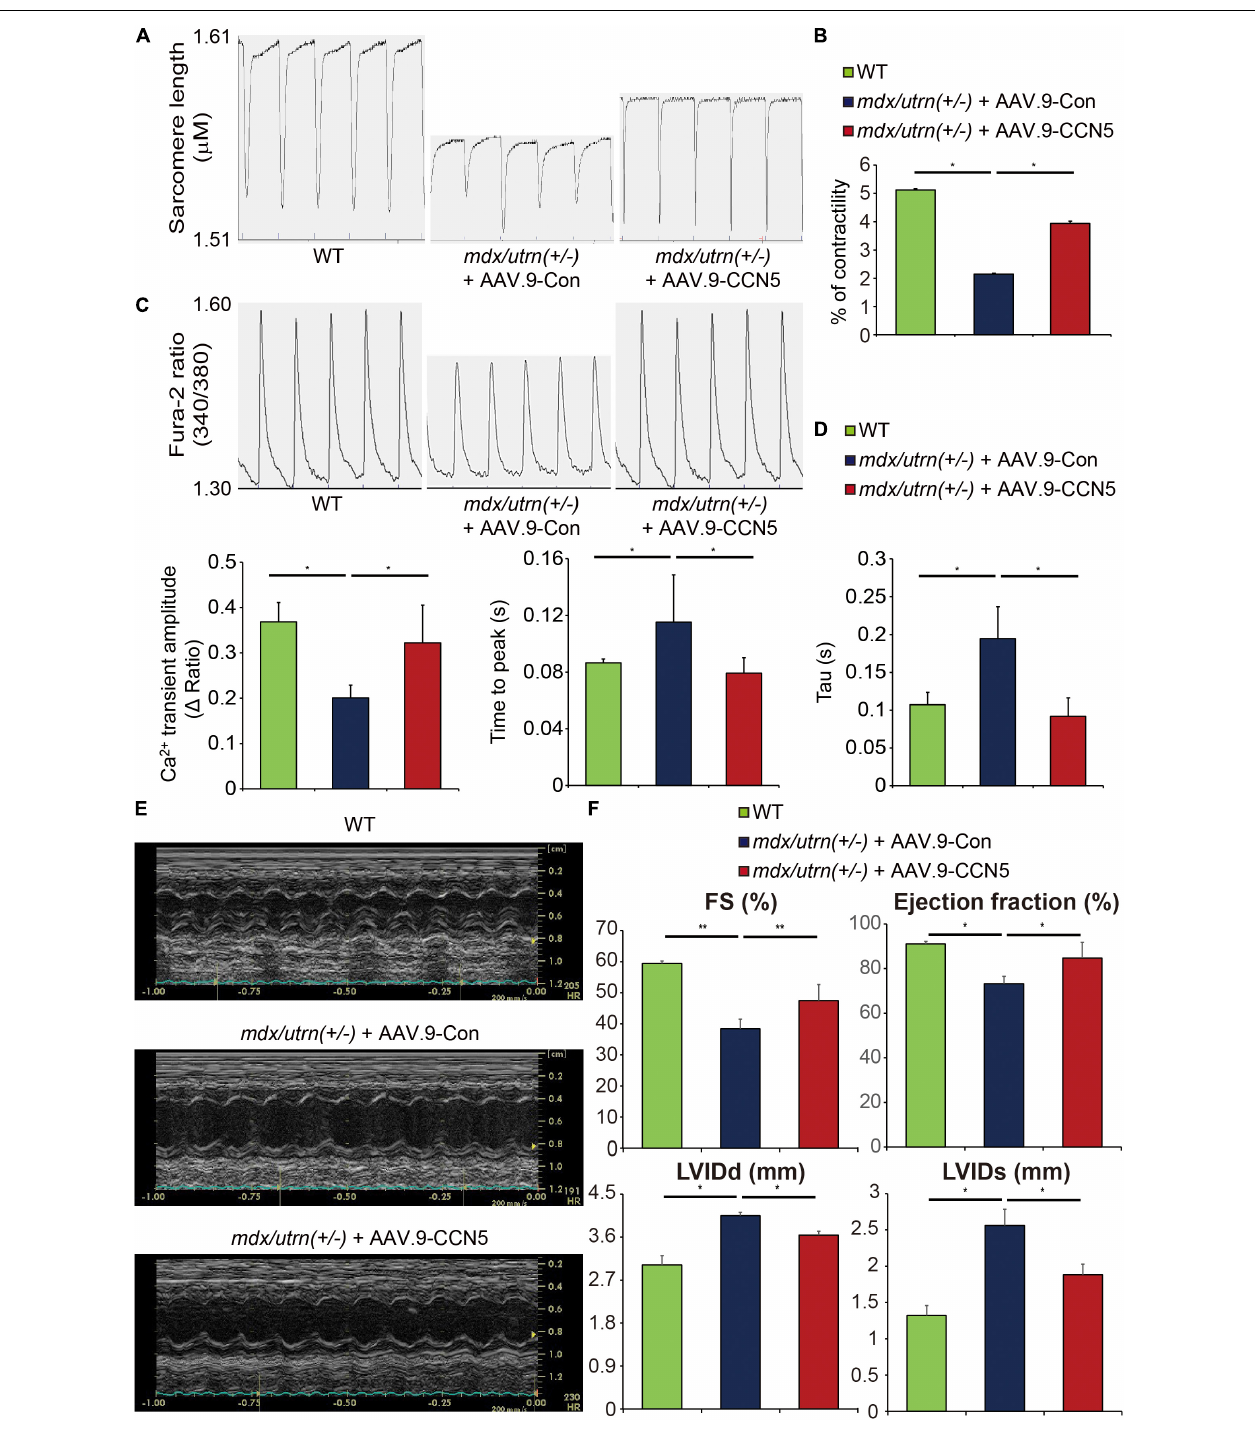
FIGURE 2 | CCN5 reduces cardiac dysfunction in mdx/utrn ( ± ) mice. (A) The Langendorff system was used to isolate cardiomyocytes. Traces of the sarcomere length were measured in the isolated cardiomyocytes. (B) Average contractility was calculated and analyzed. n ≥ 40 for analyzing the contractility. (C) Traces of the Fura-2 ratio of Ca 2 + transients were measured in the isolated cardiomyocytes. n ≥ 40 for analyzing the Ca 2 + transient parameters. (D) Average Ca 2 + transient amplitude, time to peak and Tau were calculated and analyzed. (E) Representative images of echocardiogram are shown. (F) FS, LVIDd, LVIDs and EF were measured to analyze cardiac function by echocardiography. n = 6. * p < 0.05 and ** p < 0.01.